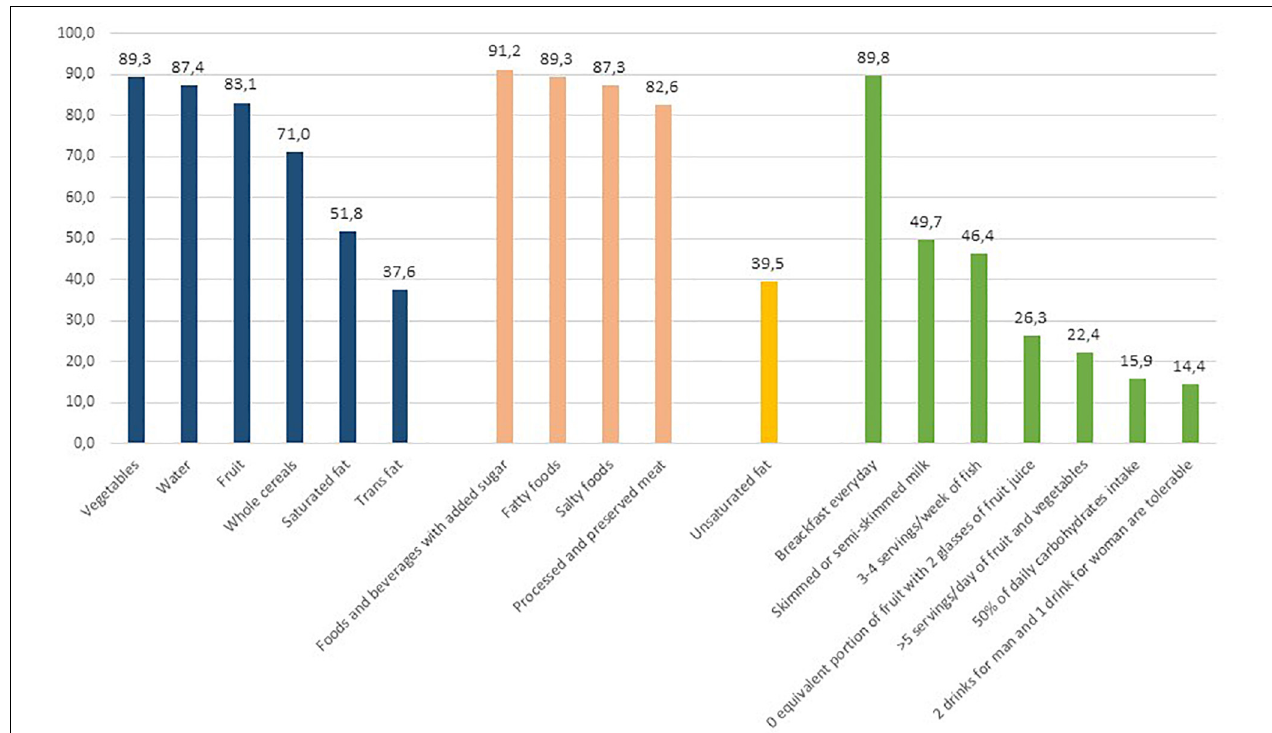
FIGURE 1 | Percentages of correct answers of the NK1-expert’s recommendations section.